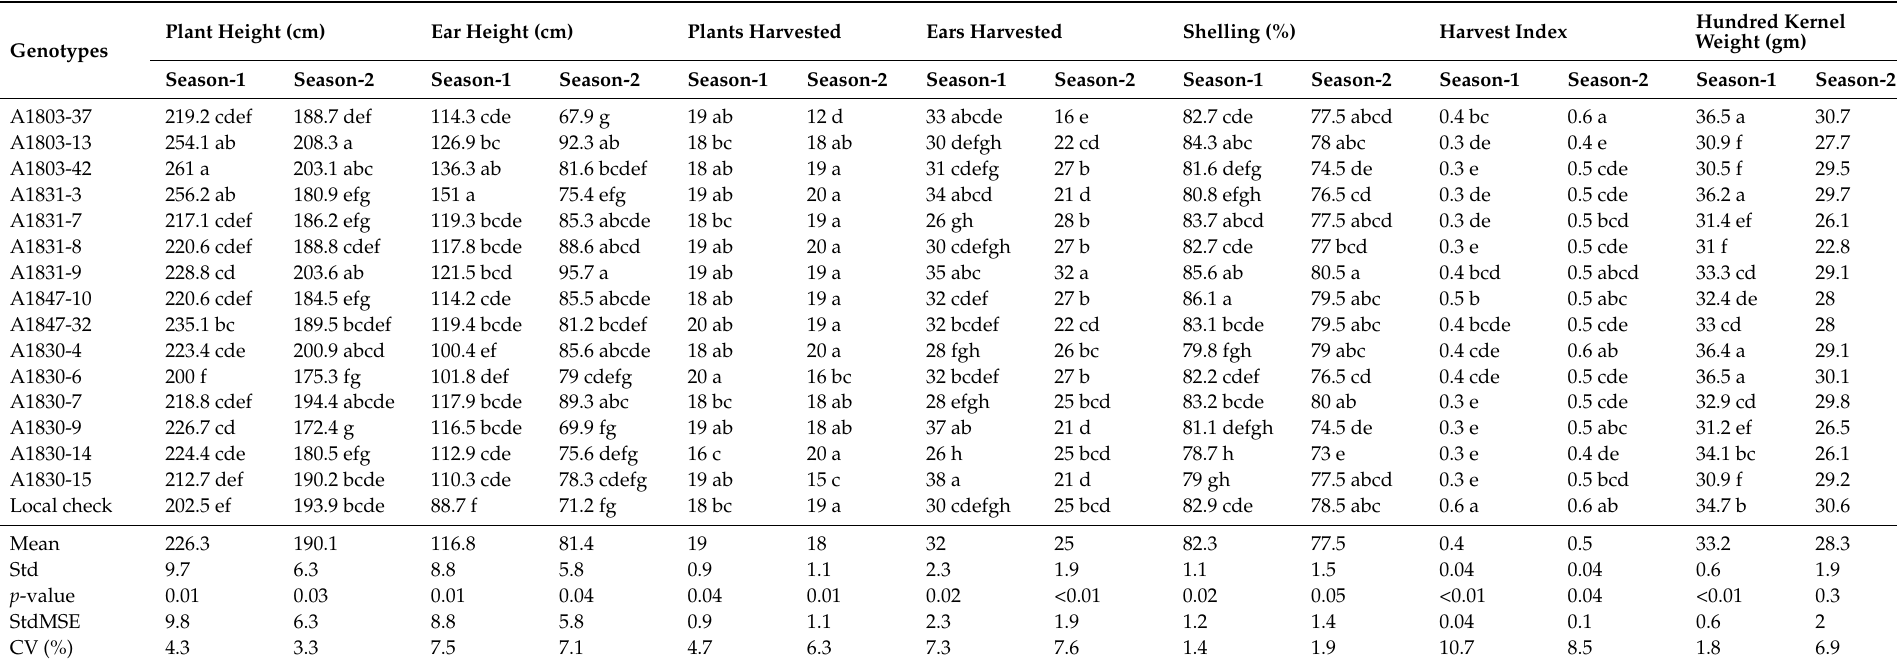
Table 5. Growth and yield attributing traits recorded in zinc biofortified maize genotypes from the two contrasting